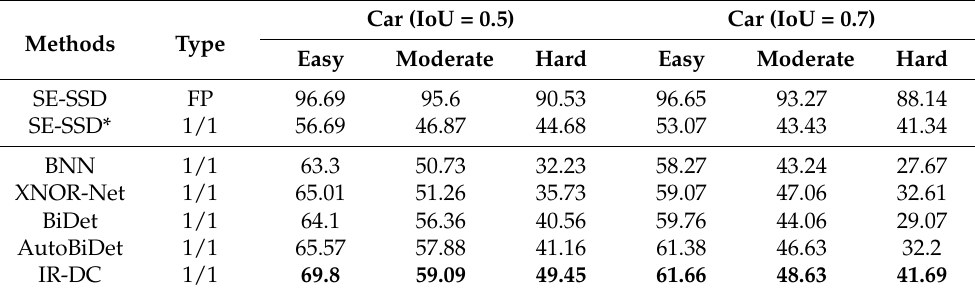
Table 4. Results of car class in KITTI.